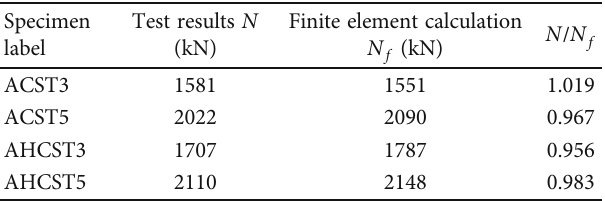
Table 7: Comparison between test results and fi nite element calculation.